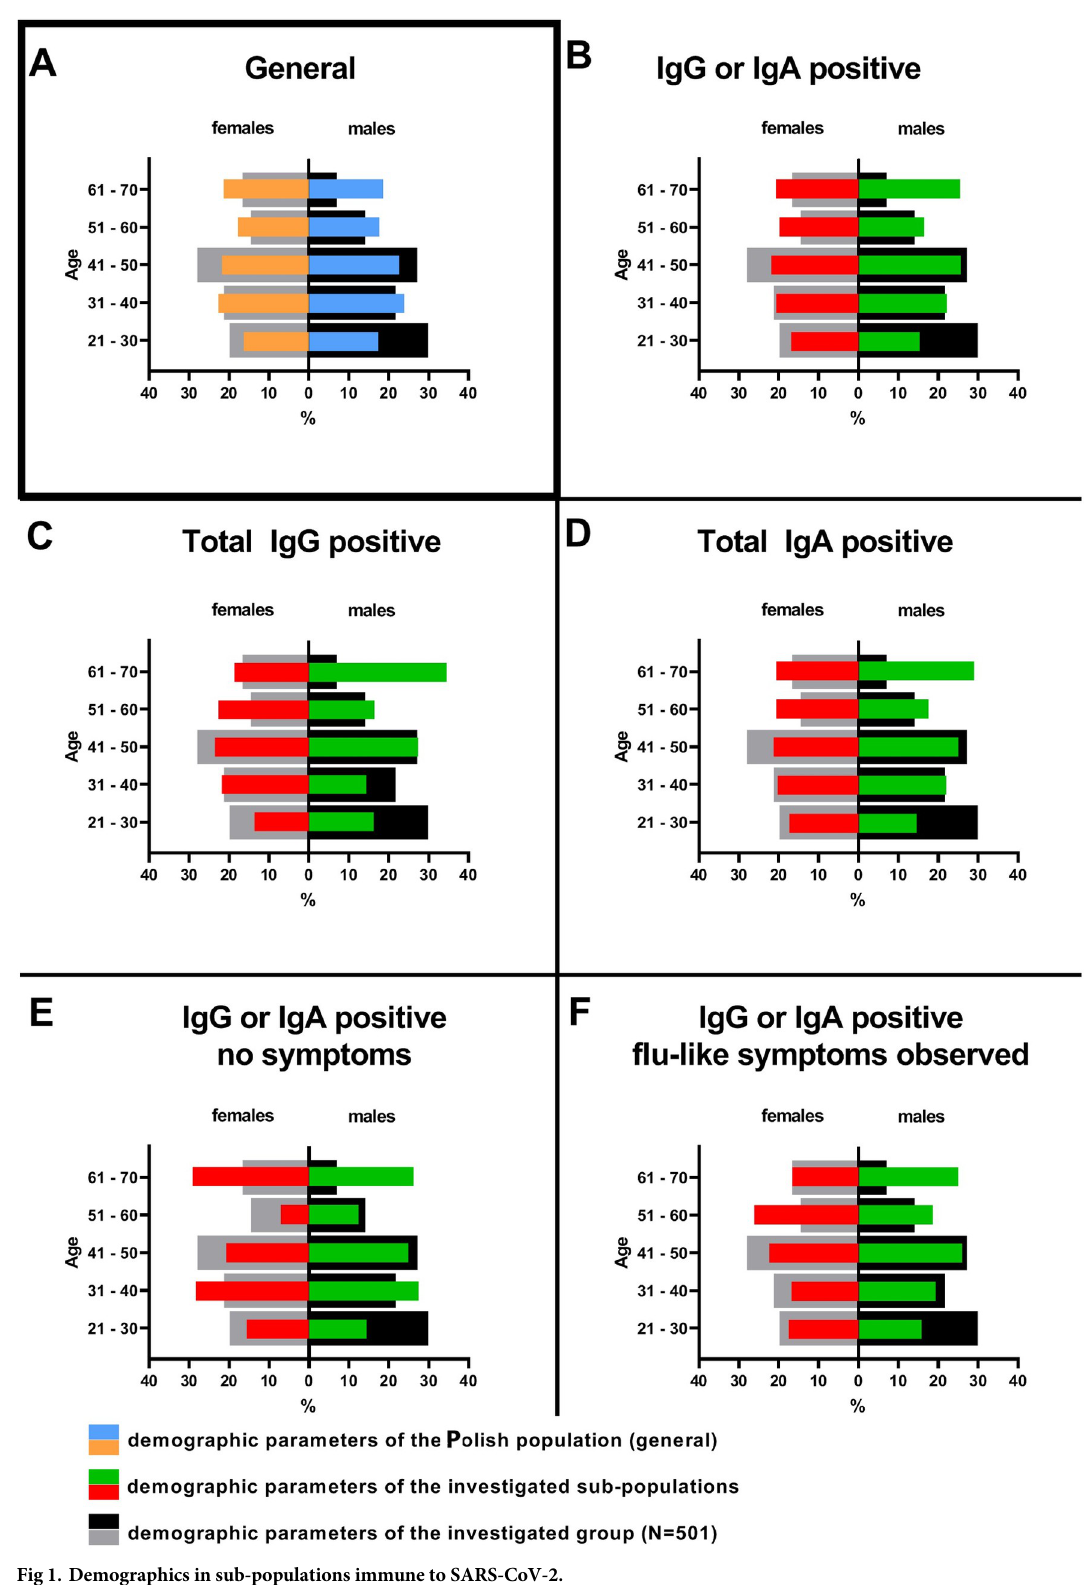
Fig 1. Demographics in sub-populations immune to SARS-CoV-2.